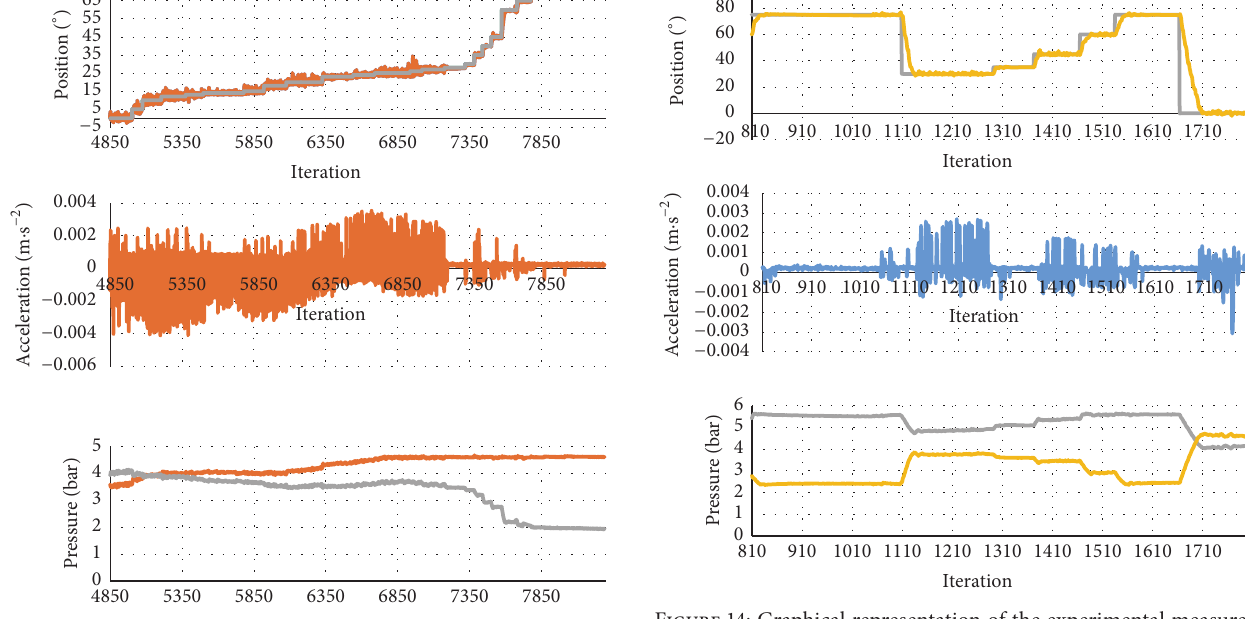
Figure 14: Graphical representation of the experimental measure- ments number 3; positioning accuracy = 1 ∘